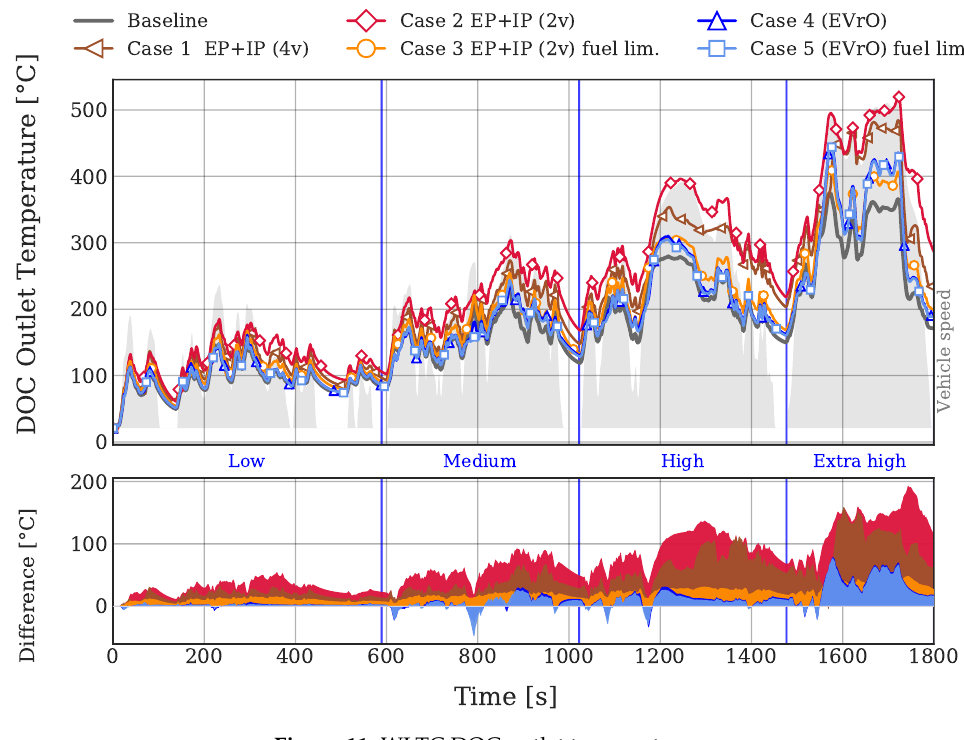
Figure 11. WLTC DOC outlet temperature.